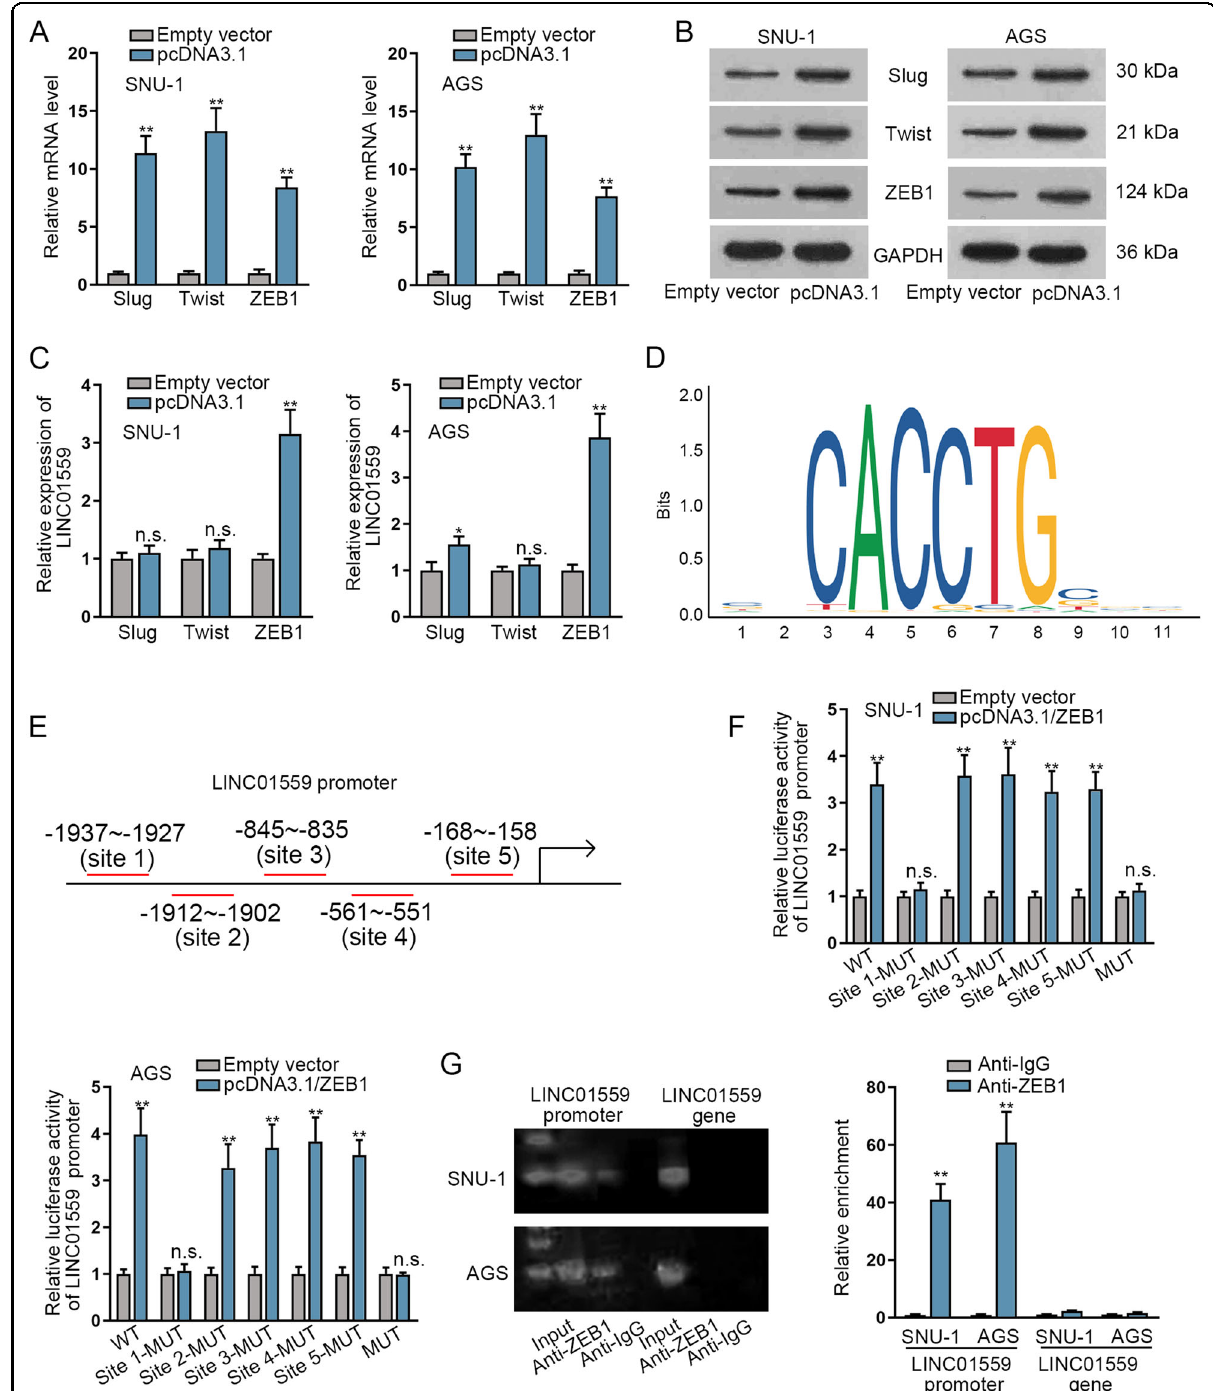
Fig. 3 ZEB1 induces the transcriptional activation of LINC01559 in GC cells. A , B RT-qPCR and western blot examined the relative mRNA level and protein level of Slug, Twist and ZEB1 in SNU-1 and AGS cells transfected with pcDNA3.1 targeting them. C RT-qPCR was used to detect the expression of LINC01559 in SNU-1 and AGS cells transfected with pcDNA3.1 targeting Slug, Twist and ZEB1. D , E JASPAR website predicted the DNA binding motif for ZEB1 and the fi ve binding sites of ZEB1 in LINC01559 promoter region. F Luciferase reporter experiments were conducted to detect the luciferase activity of indicated LINC01559 promoter in SNU-1 and AGS cells with or without ZEB1 overexpression. G ChIP assay further veri fi ed the enrichment of LINC01559 promoter in anti-ZEB1 groups. LINC01559 gene severed as the negative control of LINC01559 promoter. ** P < 0.01, n.s. meant no signi fi